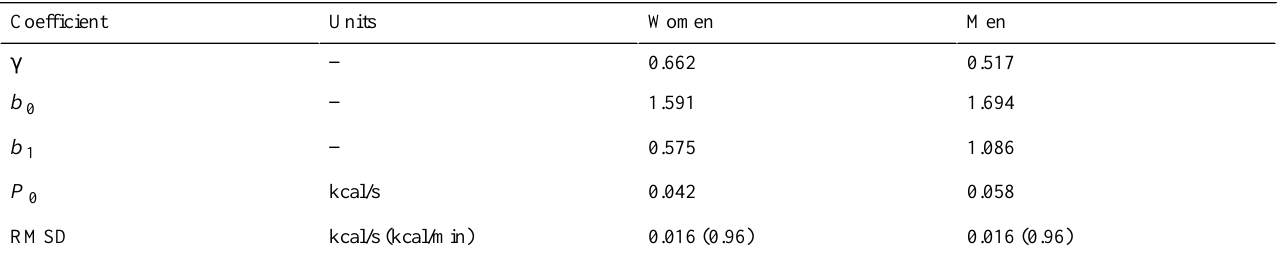
Table 1. Coefficients for the full model reported with the root-mean-square deviation (RMSD) on comparison with data. The values were obtained by two linear